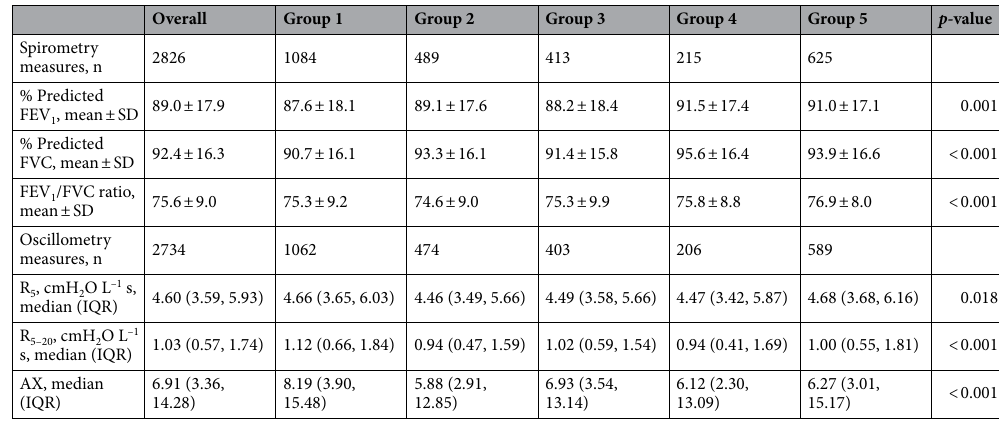
Table 2. Summary of spirometry and oscillometry measures.